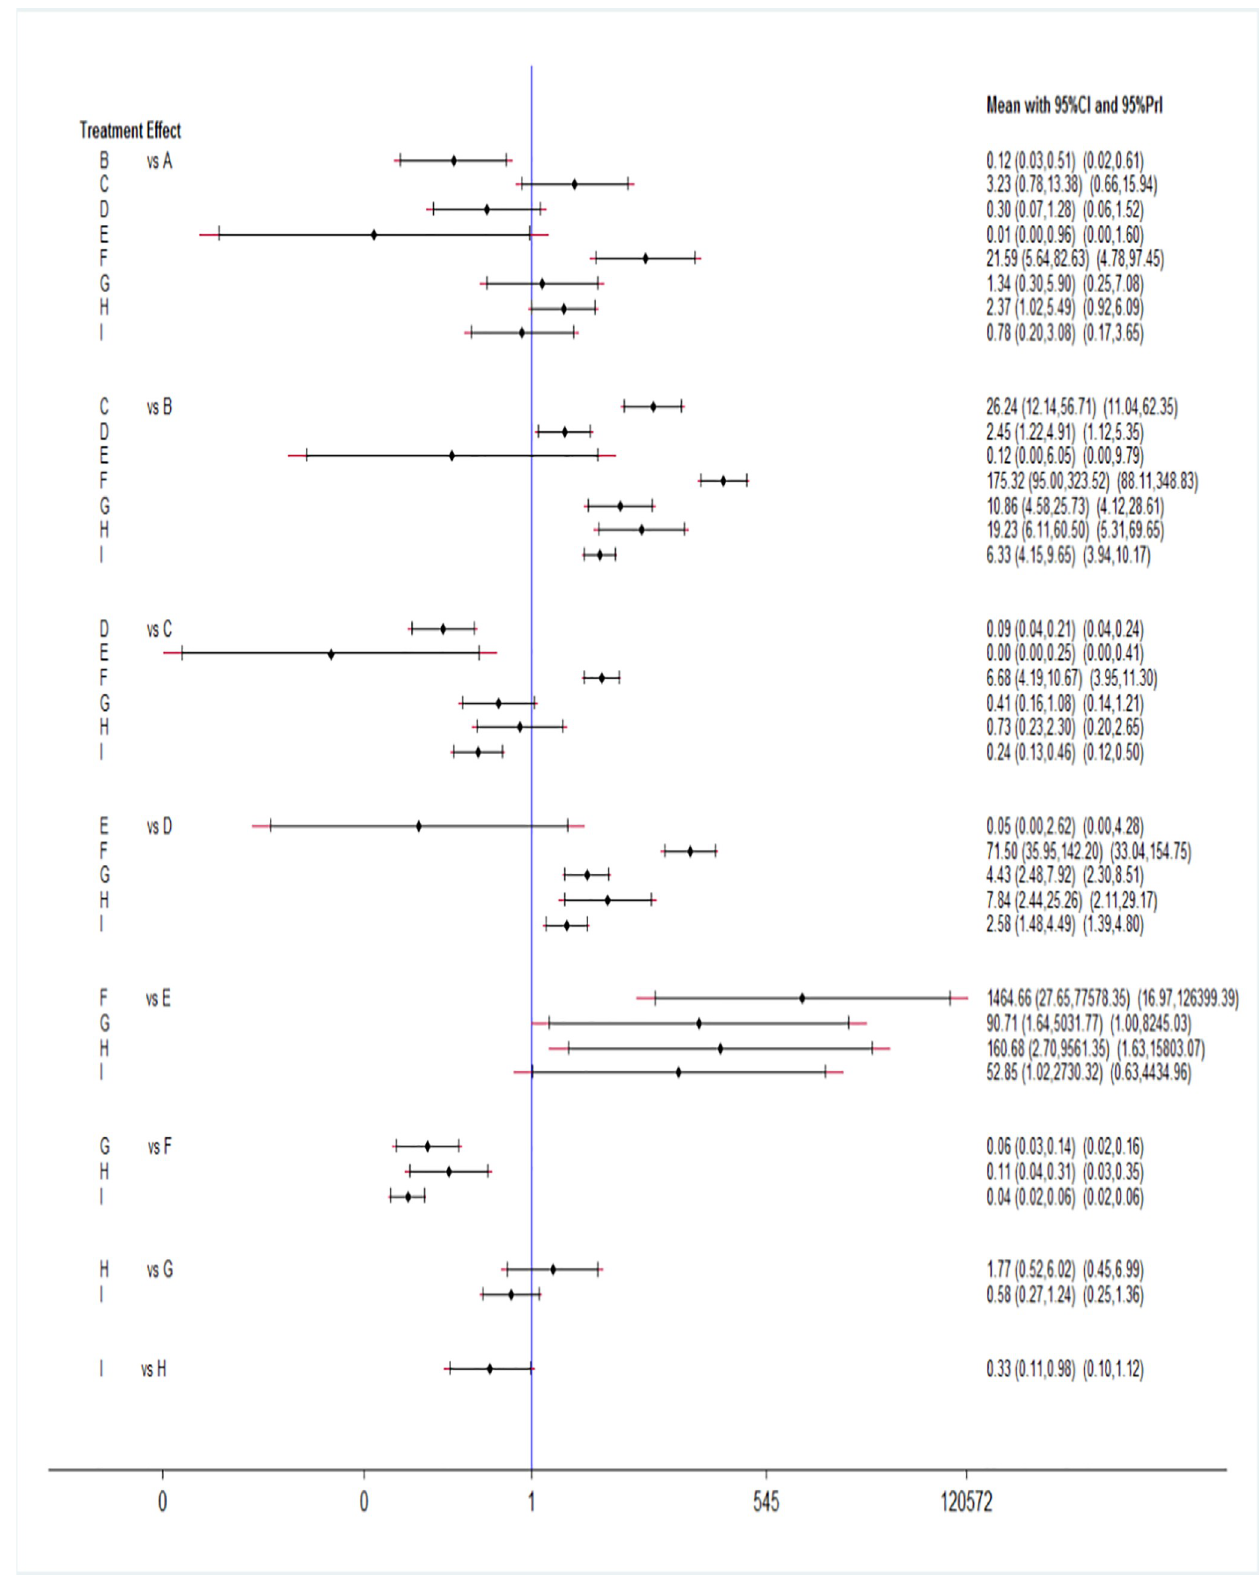
Fig 4. Forest plot of the network meta-analysis. https://doi.org/10.1371/journal.pone.0230073.g004 PLOS ONE | https://doi.org/10.1371/journal.pone.0230073 March 12,